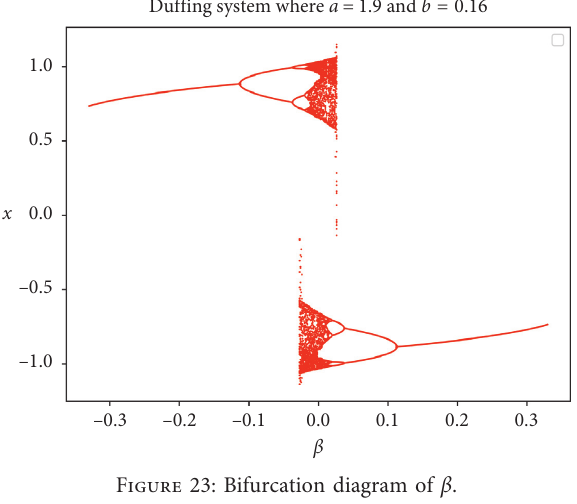
Figure 23: Bifurcation diagram of β . Duffing system where a = 1.9 and b = 0.14